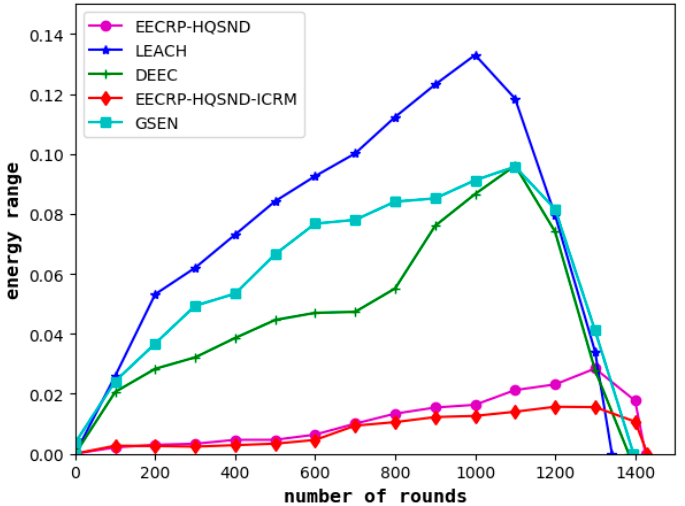
Figure 20. The range of the residual energy of the nodes in the network.